Question: Sum up the contents of this chart in one sentence.
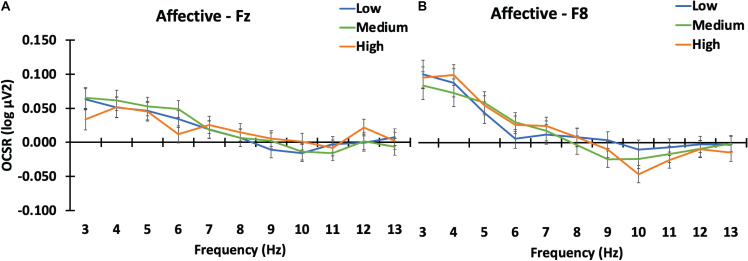
Answer: EEG power of affective groups on OCSR at Fz and F8. Note: The Y axis represents the EEG power (log µV 2 ) for the GRS (OCSR) measure. Affective groups are: low (blue); medium (green; and high (orange). The X-axis is the frequency (Hz). A . Findings at Fz. B . findings at F8. Error bars represent standard error.